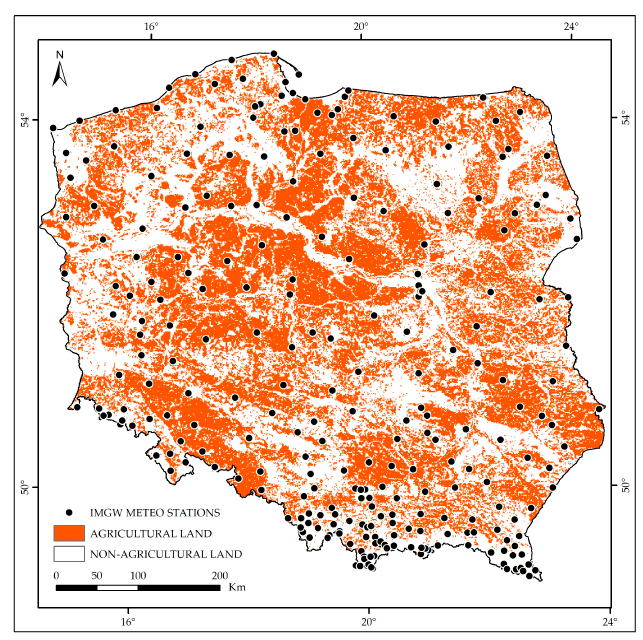
Figure 2. Locations of meteorological stations in Poland.